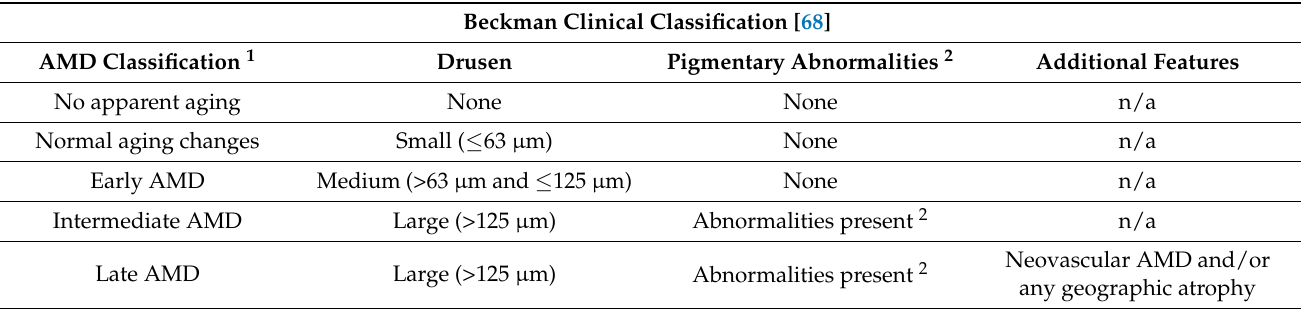
Table 2. Beckman Classification System of